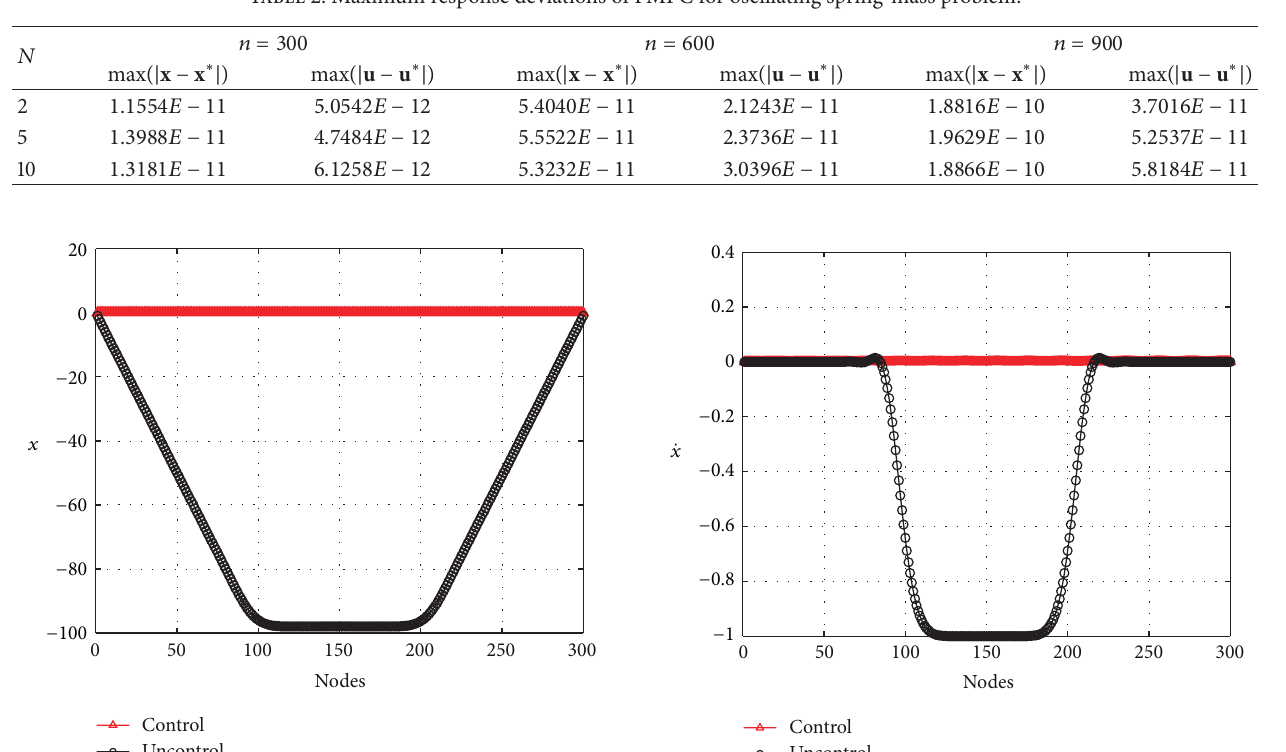
Table 2: Maximum response deviations of FMPC for oscillating spring-mass problem.